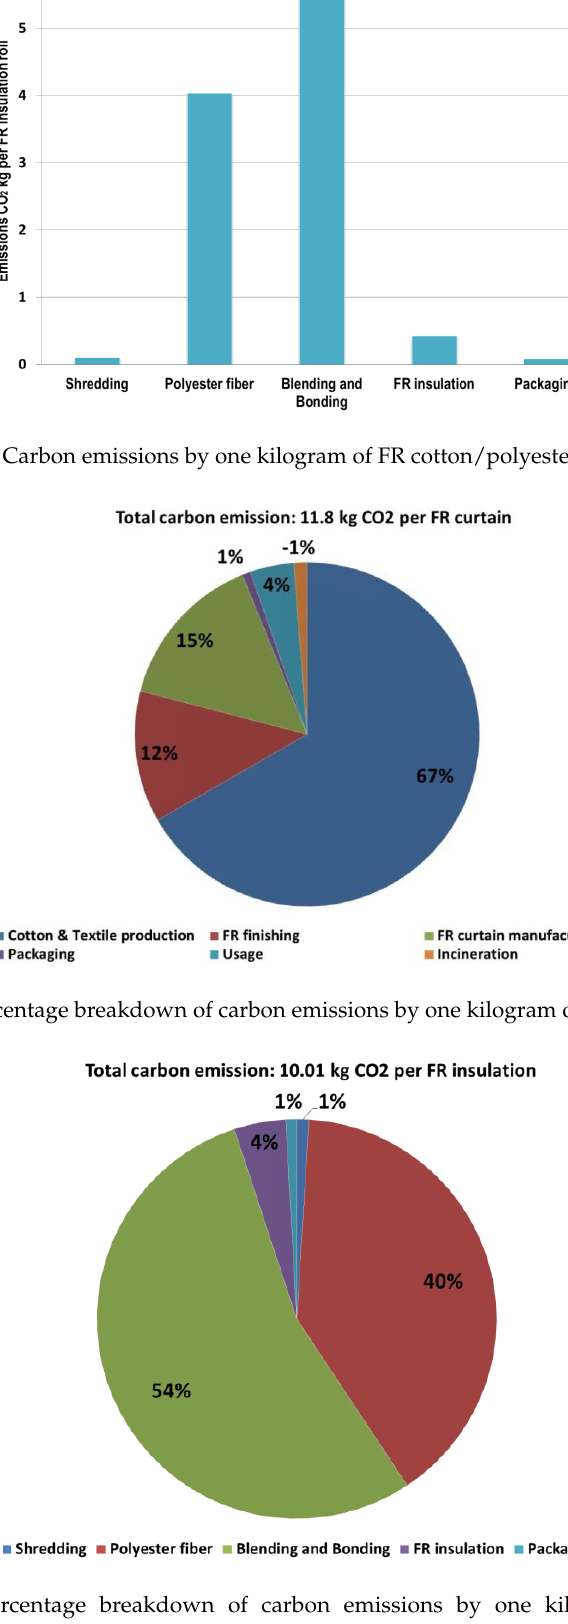
Figure 5. Carbon emissions by one kilogram of FR cotton/polyester insulation.